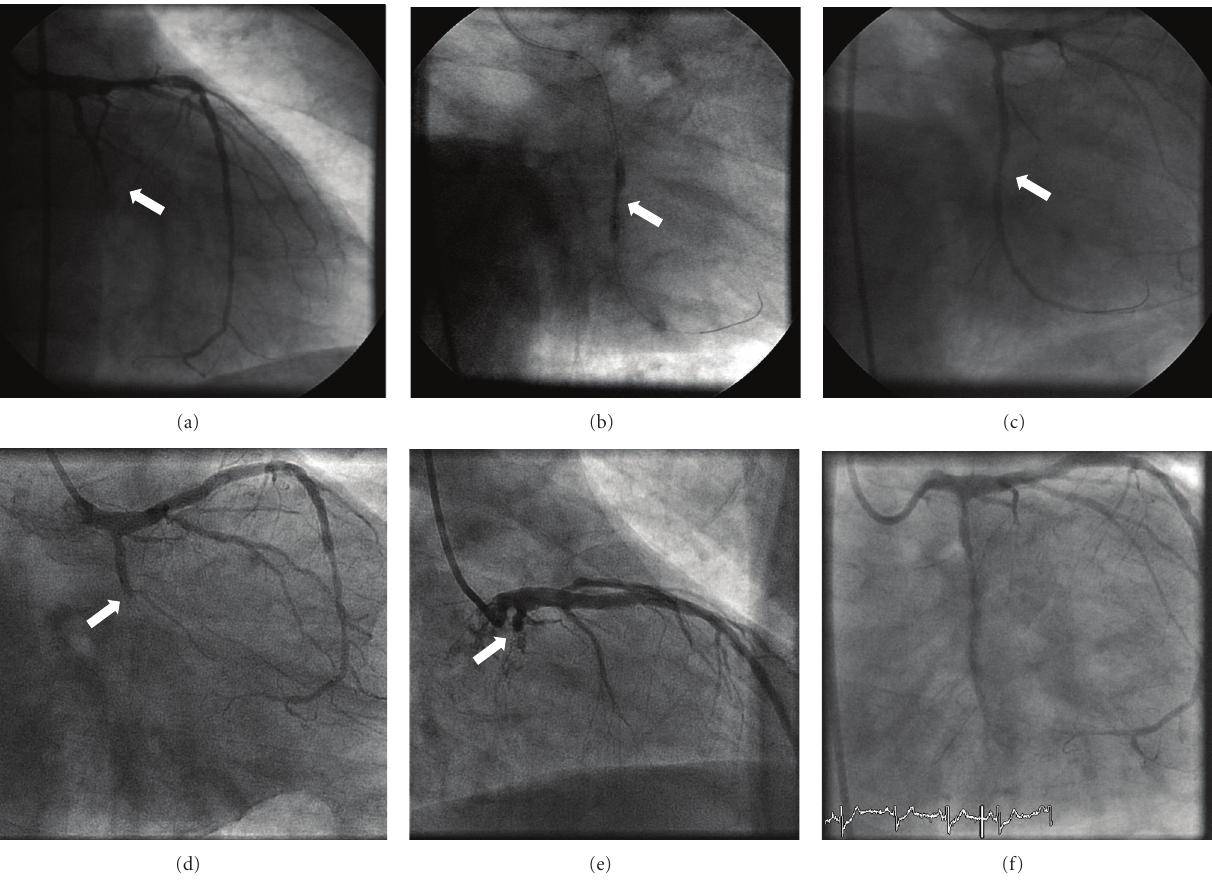
Figure 1: Angiography of the left circumflex artery showing chronic total occlusion in the mid segment (a), postdilatation of the overlap stent segment with a noncompliant balloon (b), and final result showing stent underexpansion in the overlap segment (c). Complete acute occlusion of the left circumflex artery (arrow) due to subacute stent thrombosis ((d) caudal view and (e) cranial view), and the final TIMI-1 flow after failed thrombectomy and progressive dilations of the overlapped segment with oversized noncompliant balloons